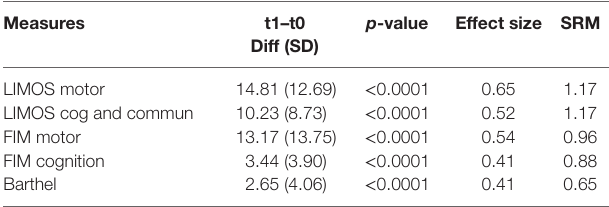
TaBle 2 | Measures of internal responsiveness (mean score difference, effect size, standardized response mean) for the liMOs motor, liMOs cognition and communication, FiM motor and cognition and Bi.